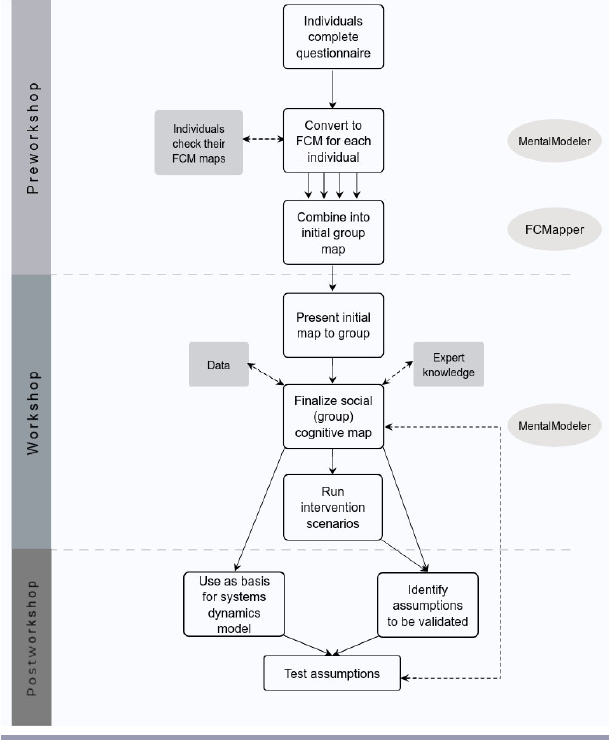
Fig. 1 . Process for participatory fuzzy cognitive mapping (FCM), illustrating three stages: preworkshop, where individual cognitive maps are elicited and combined; workshop, where the initial map is presented to a group, modified, and interventions incorporated; postworkshop where cognitive maps are used to validate assumptions. Dashed lines indicate feedbacks, and round components indicate the software used at each